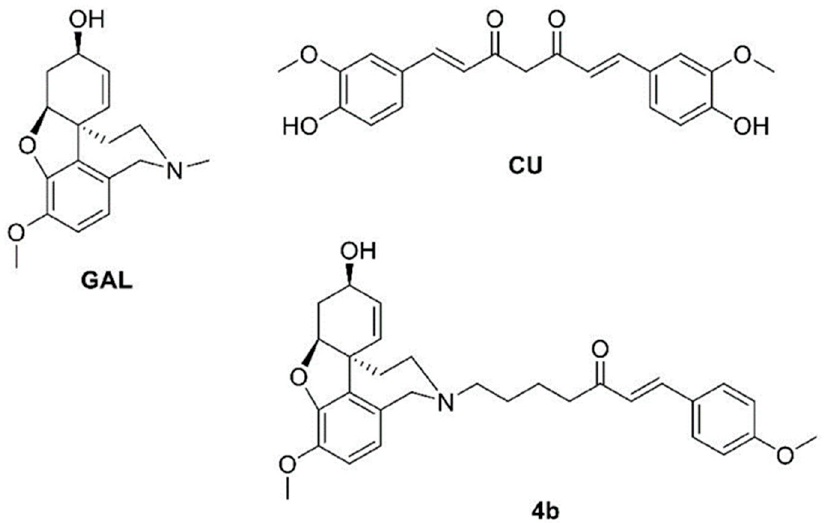
Figure 1. Structures of galantamine (GAL), curcumin (CCN) and their hybrid 4b